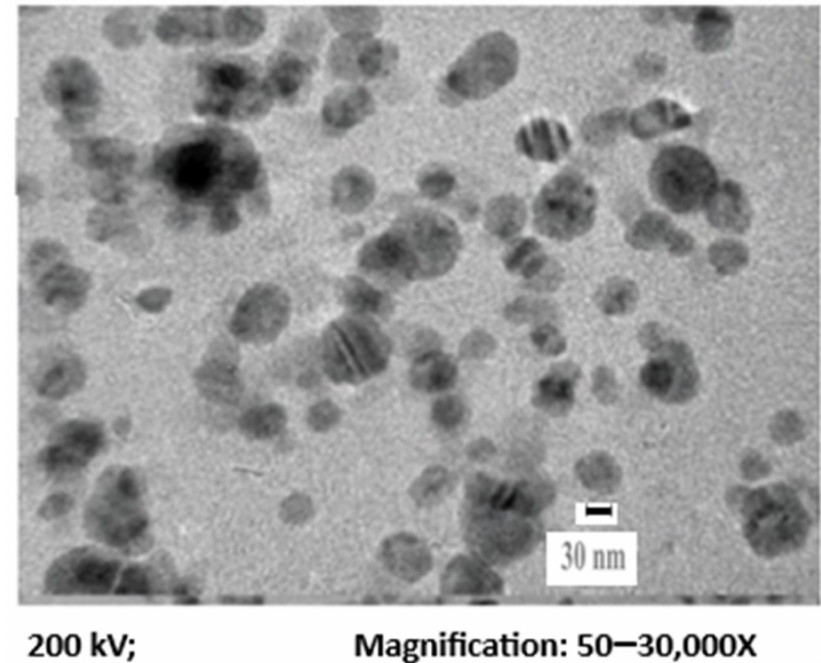
Figure 1. TEM of the synthesized